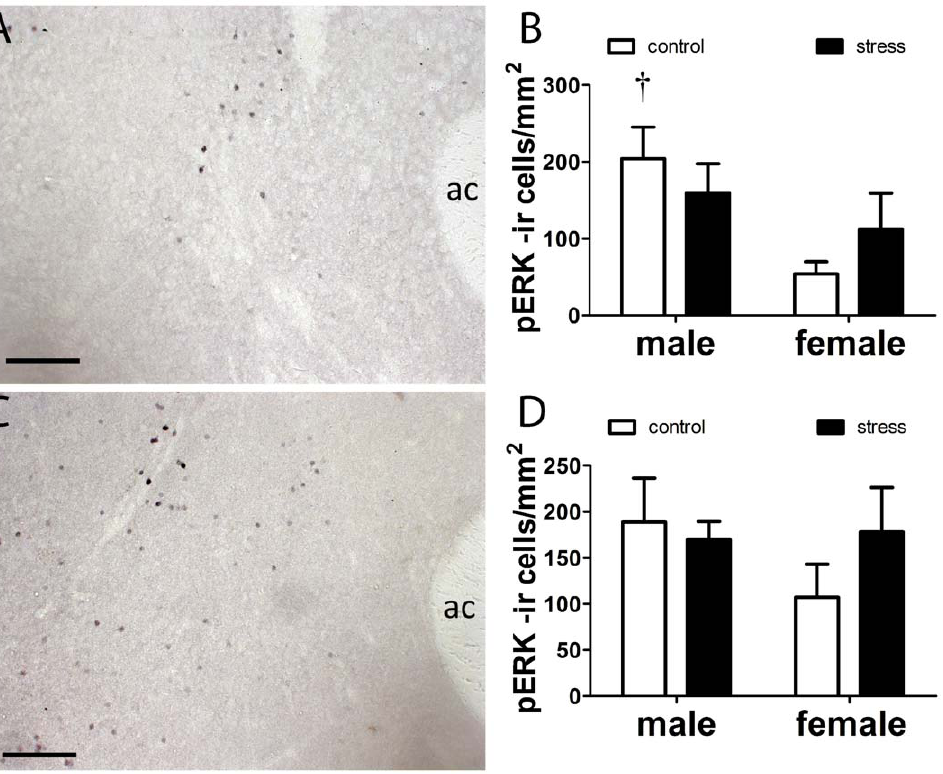
Figure 6. Immunostaining for phosphorylated ERK in female (A) and male (C) NAc. Males had more pERK positive cells than females in the NAc shell (B) but not in the NAc core (D). { Mann-Whitney sex difference in controls p , 0.05. All data are mean 6 s.e. Anterior commissure, ac. Scale bars=100 m m.